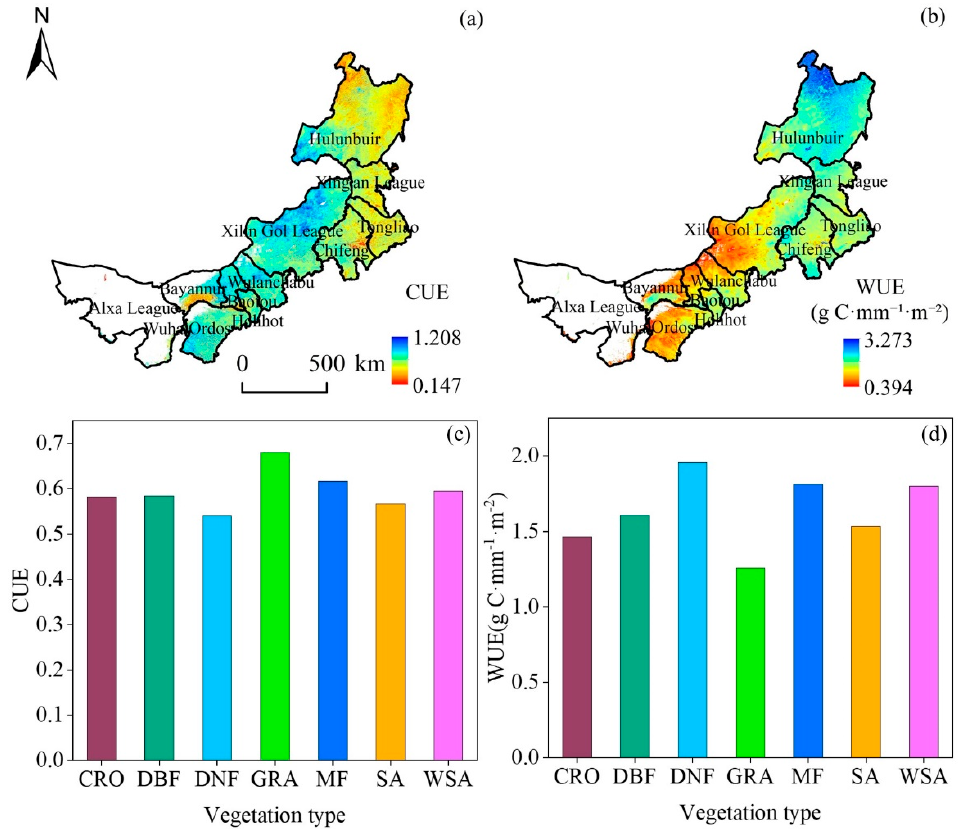
Figure 4. Spatial distribution characteristics of CUE ( a ) and WUE ( b ), and the mean values of CUE ( c ) and WUE ( d ) in different vegetation types in Inner Mongolia from 2001 to 2020.